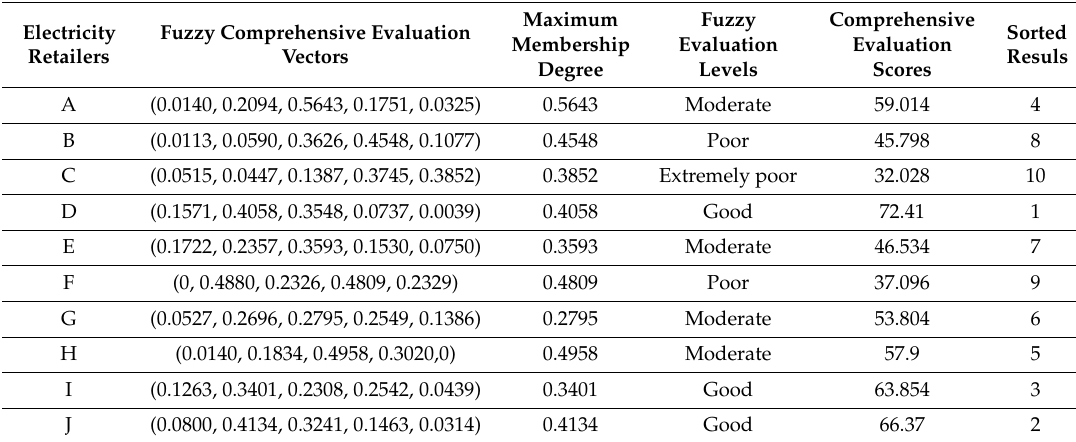
Table 10. Two-level fuzzy comprehensive evaluation